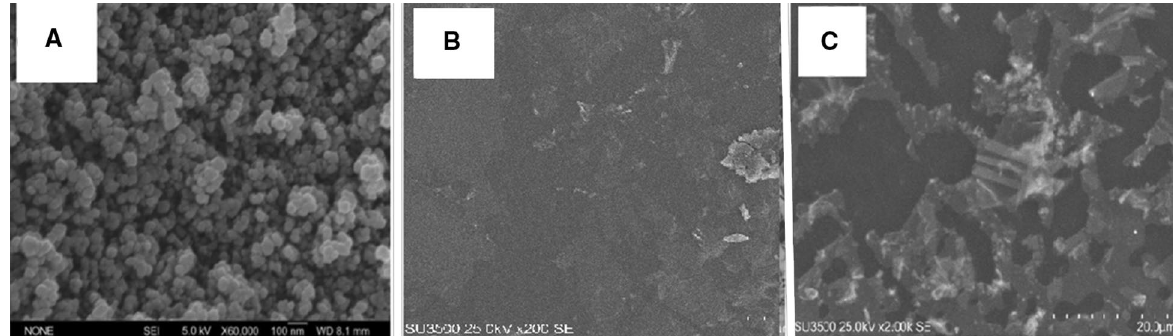
Figure 4. SEM pattern of ( A ) Fe 3 O 4 @ A. sativum ; ( B ) Fe 3 O 4 @ A. sativum /CS/PLA/PU; ( C ) (Fe 3 O 4 @ A. sativum / CS/PLA/PU-Mo-Ge)